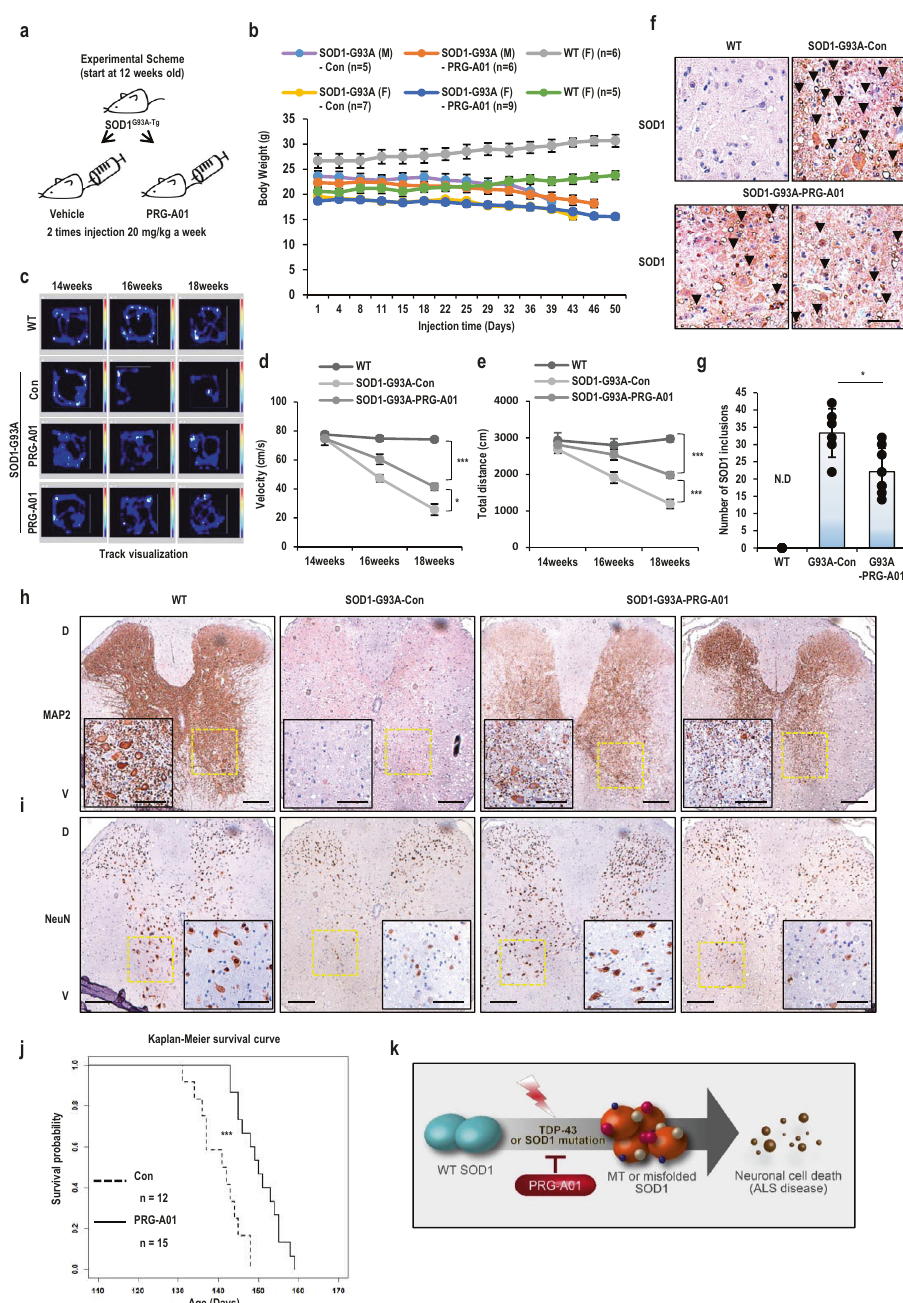
Thapsigargin (endoplasmic reticulum Ca 2 + depletor; CAS 67526-95-8) was pur- chased from Calbiochem (Darmstadt, Germany). CoCl 2 (hypoxia-inducer; C8661), Zn 2 + scavenger (TPEN; P4413) and BAPTA (Ca 2 + scavengers; A1076) were obtained from Sigma Aldrich (St, Louis, Mo, USA). Cu 2 + scavenger (ANT-224; CAS 649749-10-0) was purchased from Cayman Chemical (Michigan, USA) Chemical screening . For chemical screening, we generated an ELISA assay system 40,41 . To select WT-SOD1 and mutant SOD1 binding inhibitor, we immo- bilized WT-SOD1 recombinant protein on a 96-well plate using 0.5% paraf- ormaldehyde (PFA). After the plates were dried and washed with phosphate- buffered saline (PBS), we incubated with 50 μ M of chemicals ( fi nal concentration), followed by adding mutant SOD1-GST (A4V, G37R, G85R, G93A) proteins. After 2 h reaction, the 96-well plates were washed with PBS and blocked by 3% skim milk to remove the background. The plates were incubated with anti-GST antibody (diluted in 1:10,000) for 1h and then anti-mouse IgG-HRP (diluted in 1:50,000) for 1 h. After washing twice, plates were incubated with a 3,3 ′ ,5,5 ′ -tetra- methylbenzidine (TMB) solution (Calbiochem) for 30 min and Stop solution (1